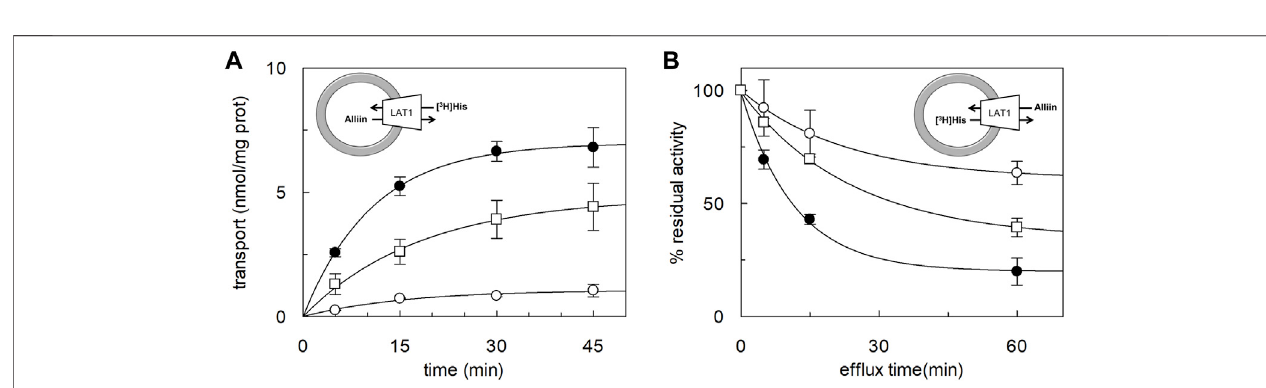
FIGURE 2 | Inhibition analysis of the recombinant hLAT1 in proteoliposomes. The reconstitution was performed as described in Materials and methods. In (A) , dose – response analysis for the inhibition by alliin of the hLAT1. Transport was measured by adding 5 µM [ 3 H]-histidine to proteoliposomes containing 10 mM histidine in the presence of indicated concentrations of alliin. Transport was stopped after 20 min as described in Materials and methods. Percent residual activity with respect to the control (withoutadditions)isreported.In (B) ,kineticanalysisoftheinhibitionbyalliin.Transportwasmeasuredbyaddingindicatedconcentrationsof[ 3 H]-histidinetoproteoliposomes containing10 mMhistidineandstoppingthereactionafter20 min;75 µM( C )or150 µM( □ )alliinwasaddedincomparisontosampleswithoutinhibitor( ○ ).Thedatawereplotted according to Lineweaver – Burk as reciprocal transport rate vs. reciprocal histidine concentration. Results are the mean ± S.D. from the three independent